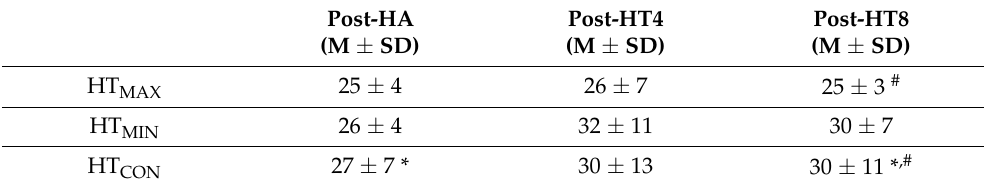
Table 1. Means and standard deviations (Ms ± SDs) of post-trial Environmental Symptoms Ques- tionnaire (ESQ) scores at baseline, after heat acclimatization (post-HAz), and after heat acclimation (post-HA). Scores for each item can range from a value of 1 (“not at all”) to 6 (“extreme”). Baseline Post-HAz a Post-HA b Lightheaded 2 ± 1 2 ± 1 1 ± 1 Headache 1 ± 1 1 ± 1 1 ± 0 Dizzy 1 ± 1 2 ± 1 1 ± 1 Thirsty 4 ± 1 3 ± 1 3 ± 1 Weak 2 ± 1 2 ± 1 2 ± 1 Grumpy 1 ± 0 1 ± 1 1 ± 1 Hard to breathe 2 ± 1 1 ± 1 1 ± 0 Play at my best 3 ± 1 3 ± 1 4 ± 1 Muscle cramp 1 ± 0 1 ± 1 1 ± 0 Tired 3 ± 1 3 ± 1 3 ± 1 Sick to stomach 1 ± 1 1 ± 1 1 ± 1 Hot 4 ± 1 4 ± 1 3 ± 1 Trouble concentrating 2 ± 1 2 ± 1 1 ± 1 Chills 1 ± 0 1 ± 0 1 ± 0